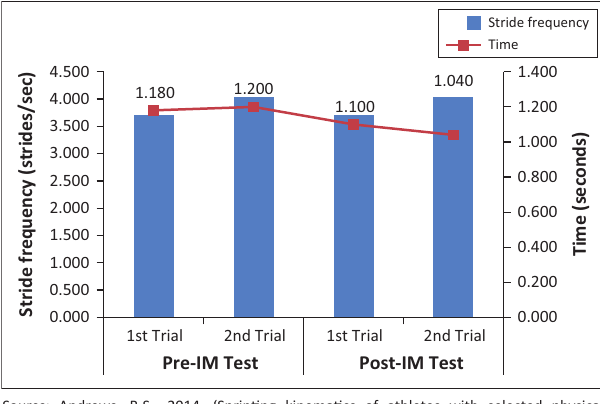
FIGURE 8: Effect of stride frequency during 10 m of the maximal running velocity phase, on